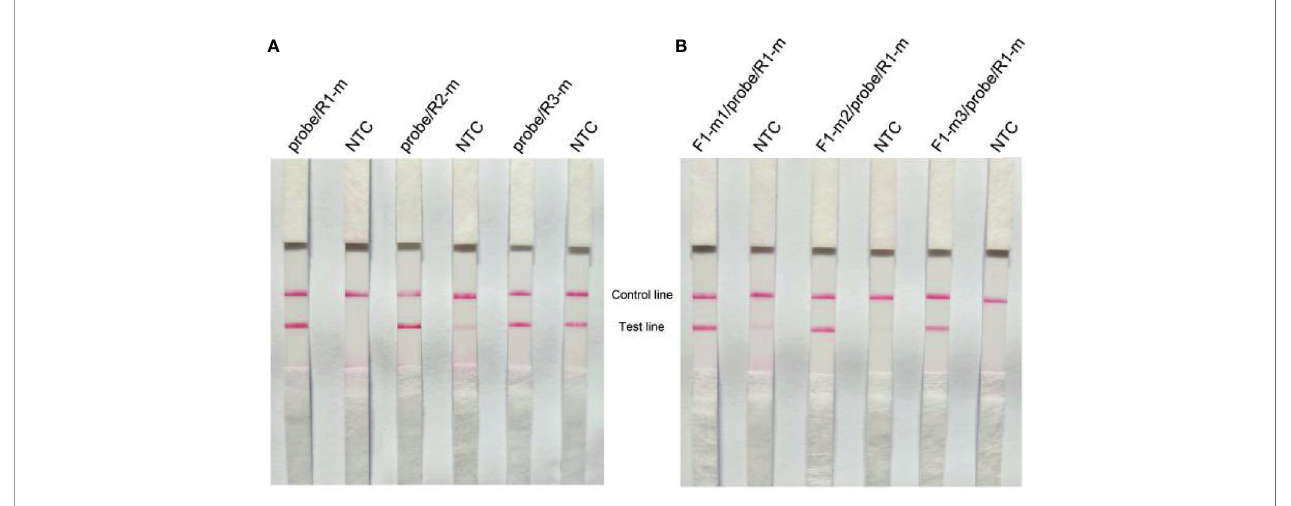
FIGURE 2 | RPA-LFS primer and probe sets screen. (A) Probe-reverse primer sets of probe/R1-m, probe/R2-m, and probe/R3-m were screened using RPA assays with genomic DNA from standard strains of P. aeruginosa as the templates. A no template control (NTC) for each primer set was used as the negative control. Equal volumes of ampli fi cation products (5 m L) were detected using LFS. (B) Forward primer-probe/R1-m sets of F1-m1/probe/R1-m, F1-m2/probe/R1-m, F1-m3/probe/R1-m were screened using RPA assays with genomic DNA of standard strains of P. aeruginosa as the templates. A NTC for each primer set was used